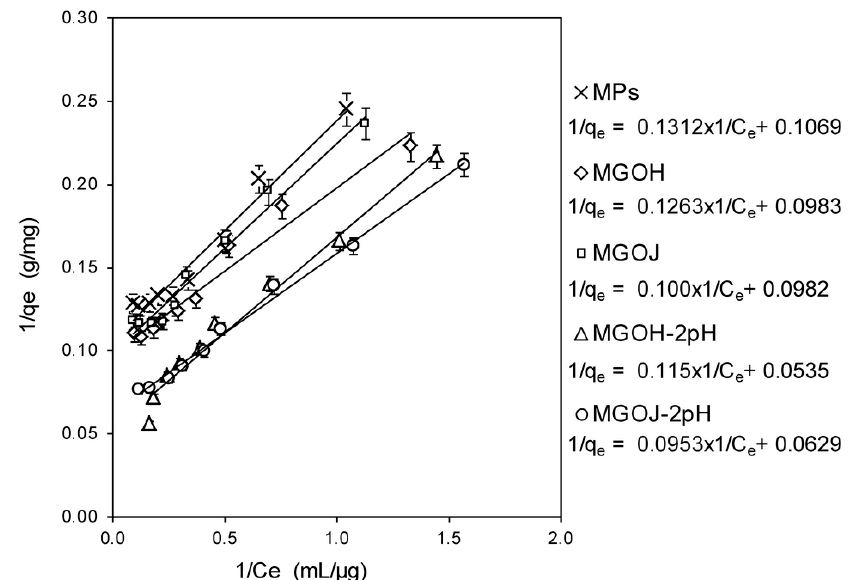
Figure 7. The Langmuir isotherms of the adsorption behavior of Se(IV) on MPs, MGOH, MGOJ, MGOH-2pH, and MGOJ-2pH. Table 3. Langmuir adsorption isotherm’s parameters for the removal of Se(VI) from its aqueous